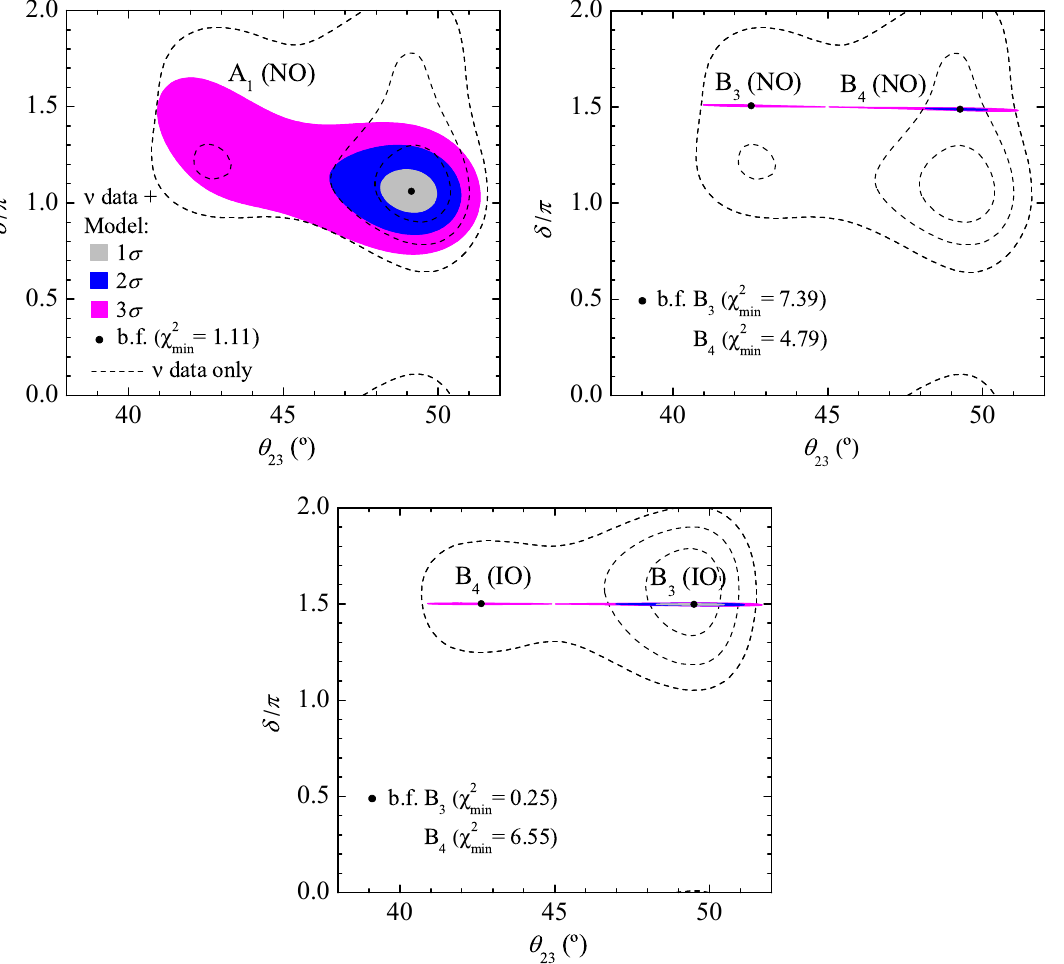
Figure 3 . Allowed regions at the 1, 2 and 3 σ level (in grey, blue and magenta, respectively) in the plane ( θ , δ ), for case A and NO (upper left plot), B 23 1 and IO (lower plot). The black dots mark the best-fit value for each case, while the dashed contours correspond to the χ 2 contours at 1, 2 and 3 σ , allowed by the global fit of neutrino oscillation data.